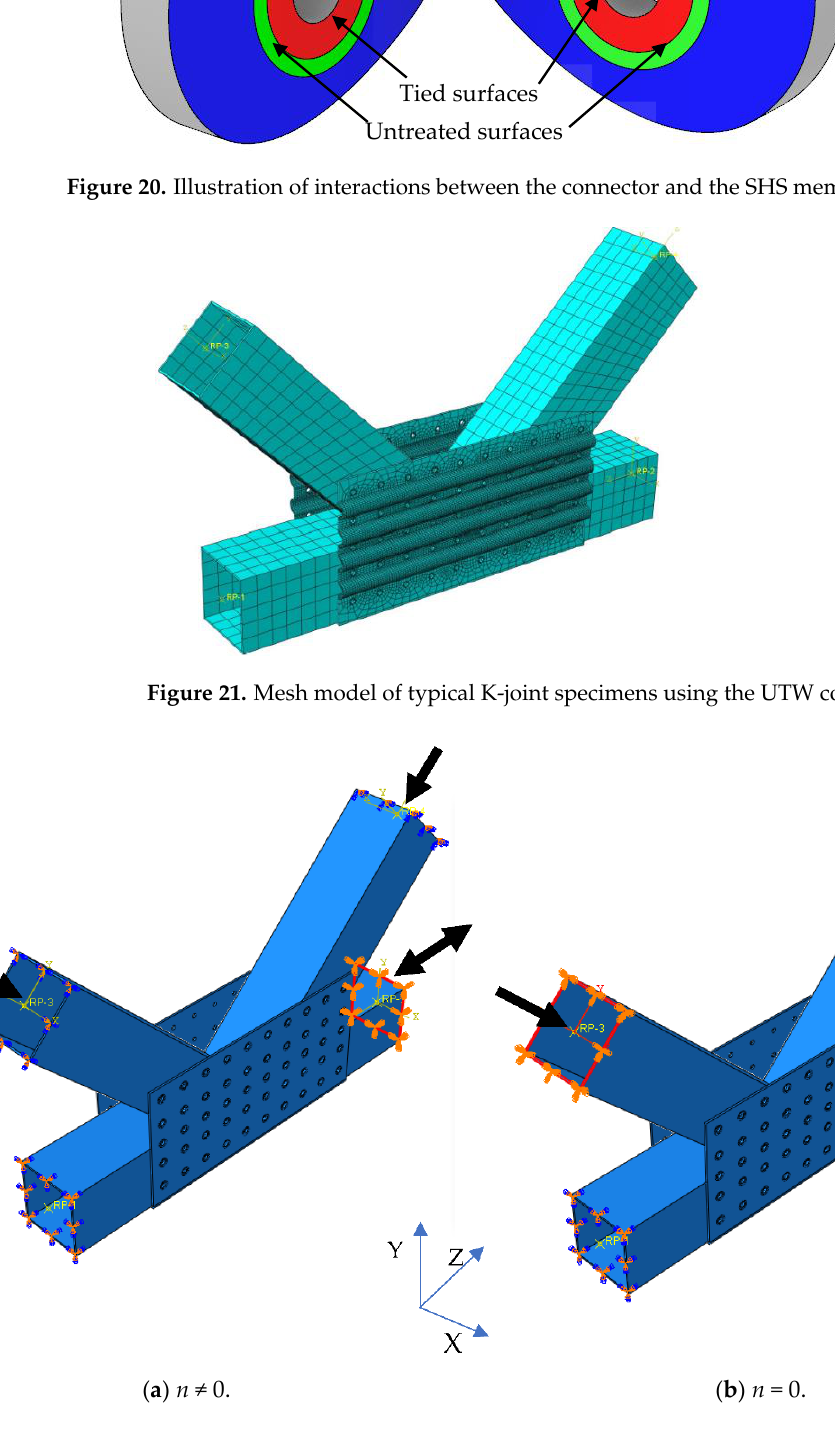
Figure 22. Boundary conditions of FE models.